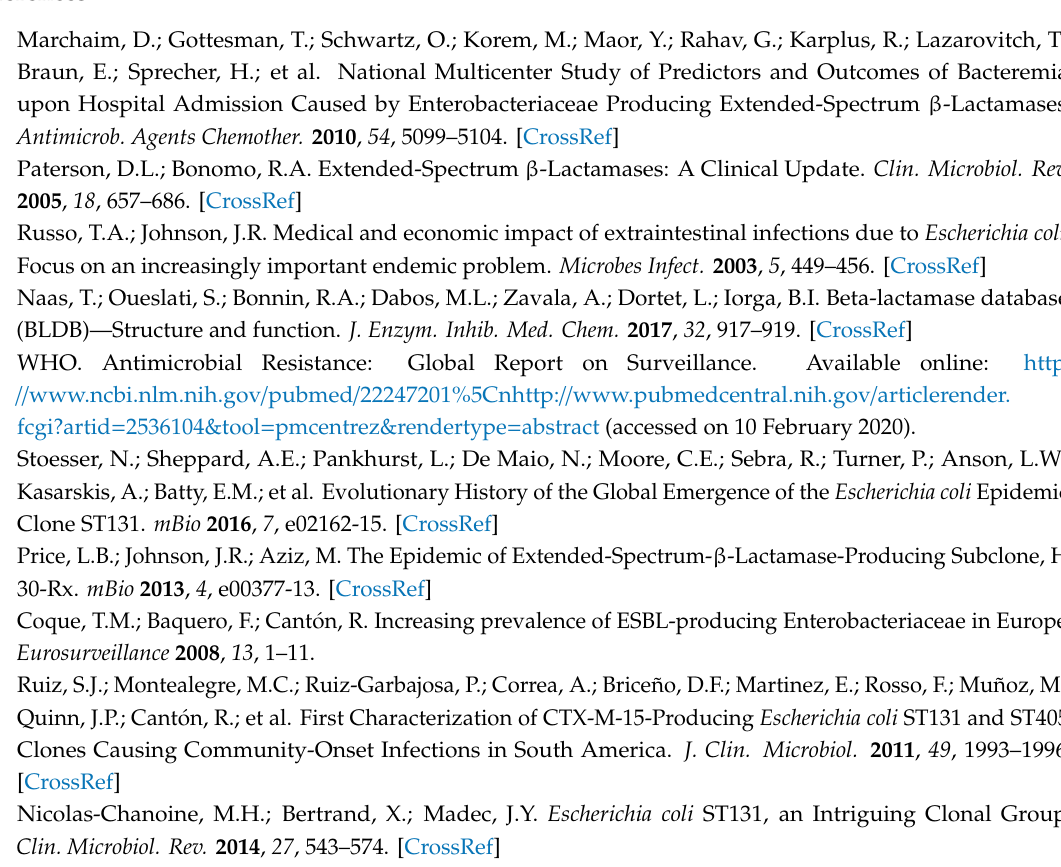
Figure S1: Virulence genotypes and incompatibility plasmids of the studied